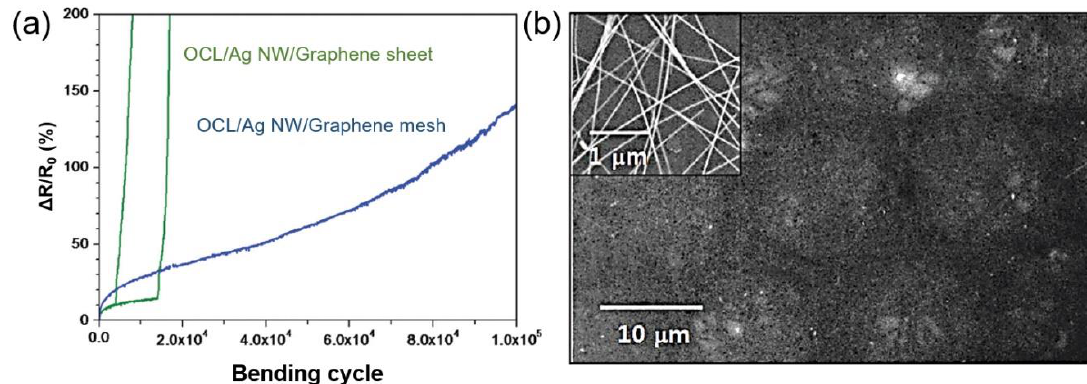
Figure 18. ( a ) Comparative resistance change of the electrodes of OCL / Ag NW / graphene sheet and the OCL / Ag NW / graphene mesh hybrid film as a function of bending cycles (bending radius: 1 mm, strain: 6.5%). ( b ) SEM images of Ag NW / graphene mesh hybrid film after cyclic bending tests [83].